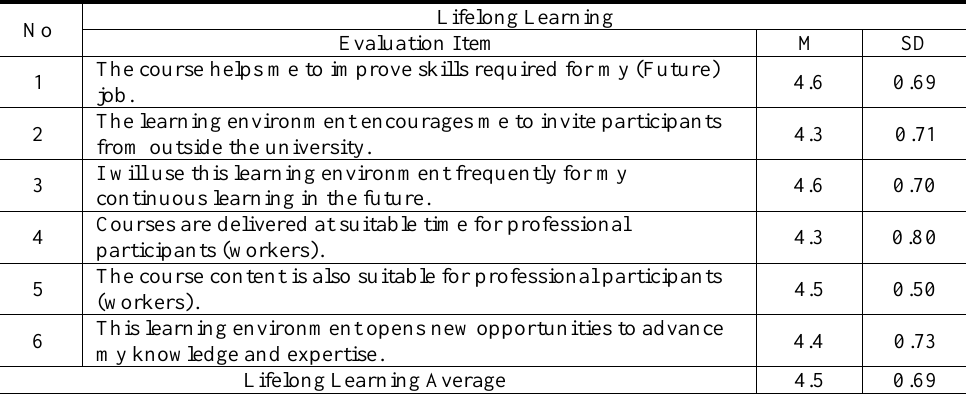
Descriptive Results of Lifelong Learning (N=50)